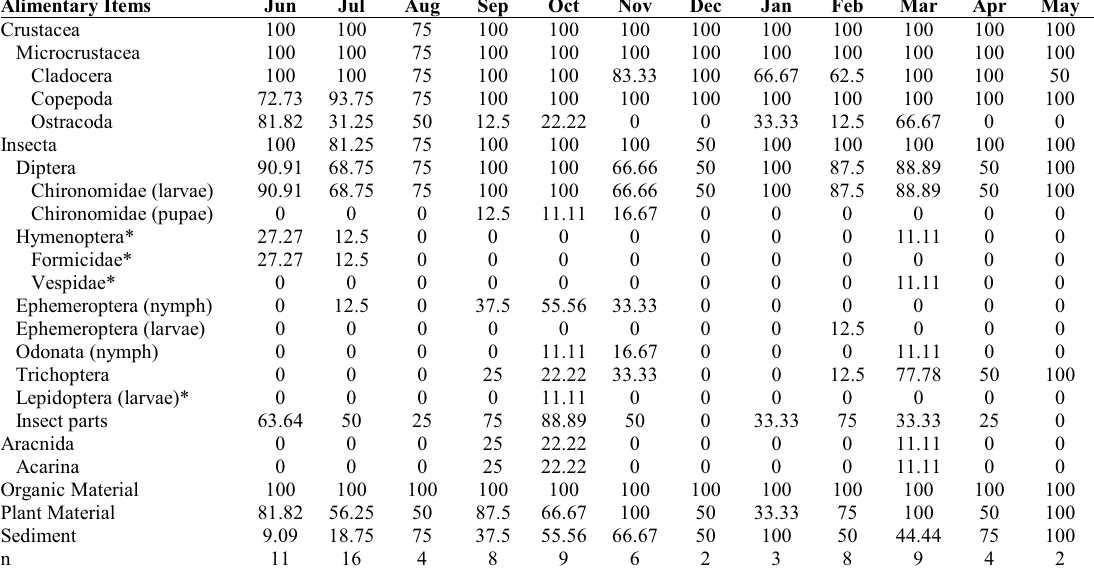
Table 2. Frequency of occurrence of identified food items for E. trilineata juveniles (*=allochthonous origin). Alimentary Items